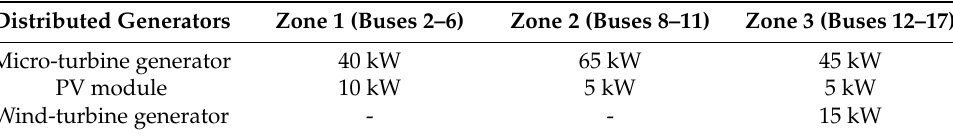
Table 2. Real power outputs from different distributed